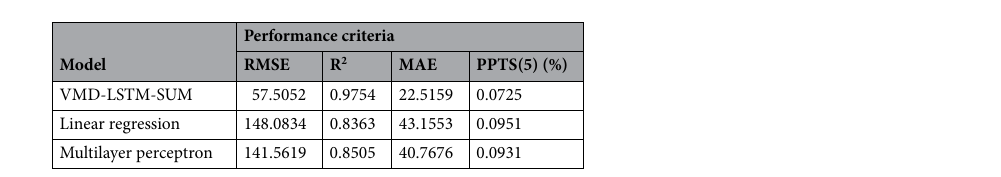
Table 4. The forecasting performances using the proposed model VMD-LSTM-SUM on the Huaxian hydrological station.